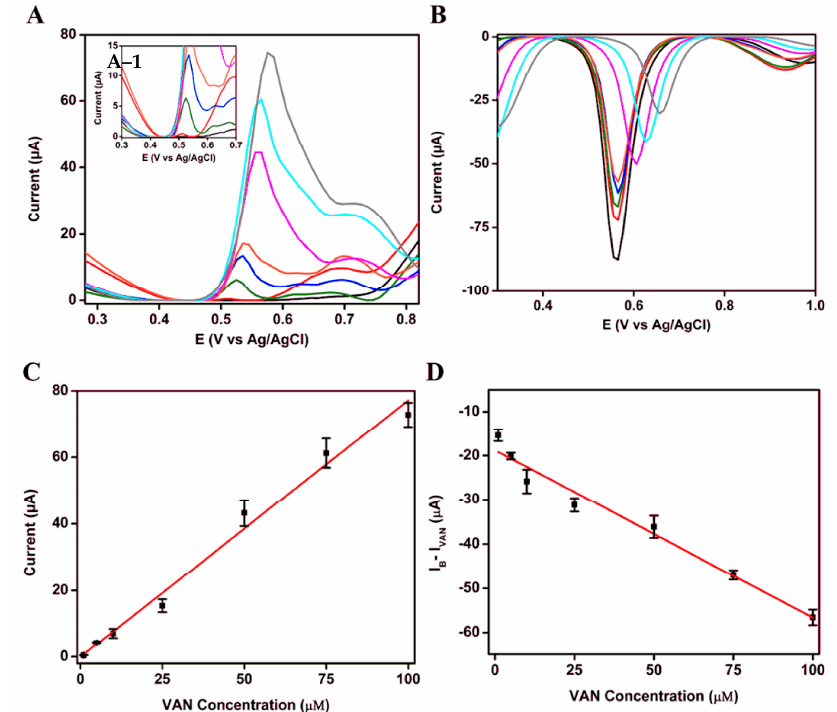
Figure 6. (First row) DPVs in oxidation ( A ) and in reduction ( B ) at AuNS–G–SPE of 1 µ M (red), 5 µ M (green), 10 µ M (blue), 25 µ M (orange), 50 µ M (pink), 75 µ M (cyan), and 100 µ M (grey) vancomycin solution in 0.1 M H 2 SO 4 (blank) (( A–1 )—zoomed area); (Second row) Linear relationship between the response in oxidation ( C ) and the response in reduction ( D ) for VAN concentration from 1 to 100 µ M.